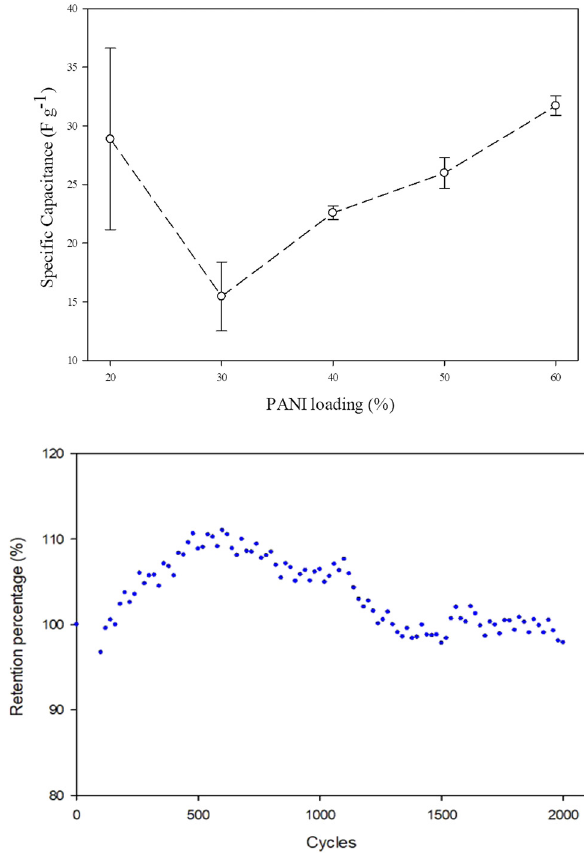
Figure 4: ( up ) Speci fi c capacitance and the area under CV curve of CPEC with di ff erent PANI contents at the scan rate 40 mV s − 1 from CV. ( down ) Retention percentage of CPEC for 2,000 cycles.